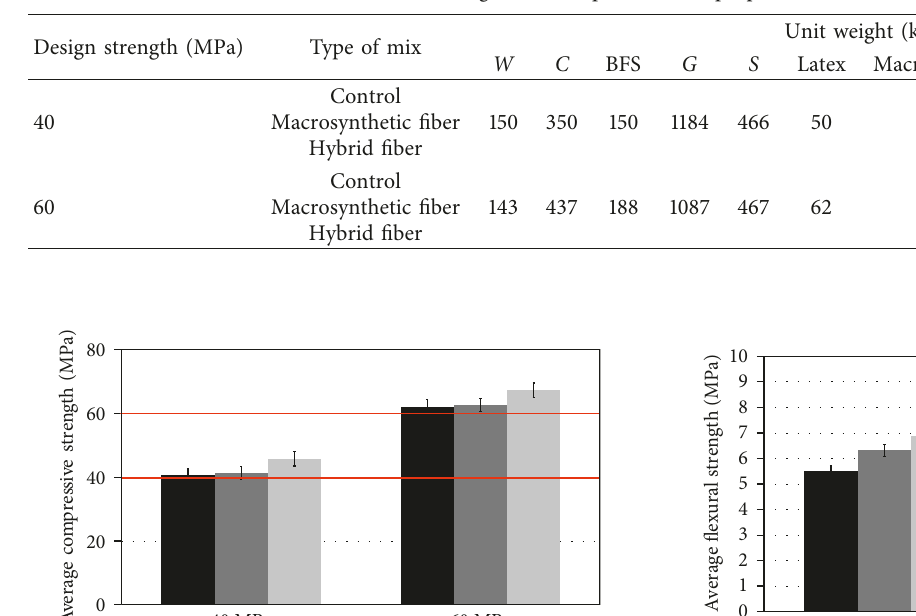
Table 9: Mixing ratio for optimum mix proportions determination.